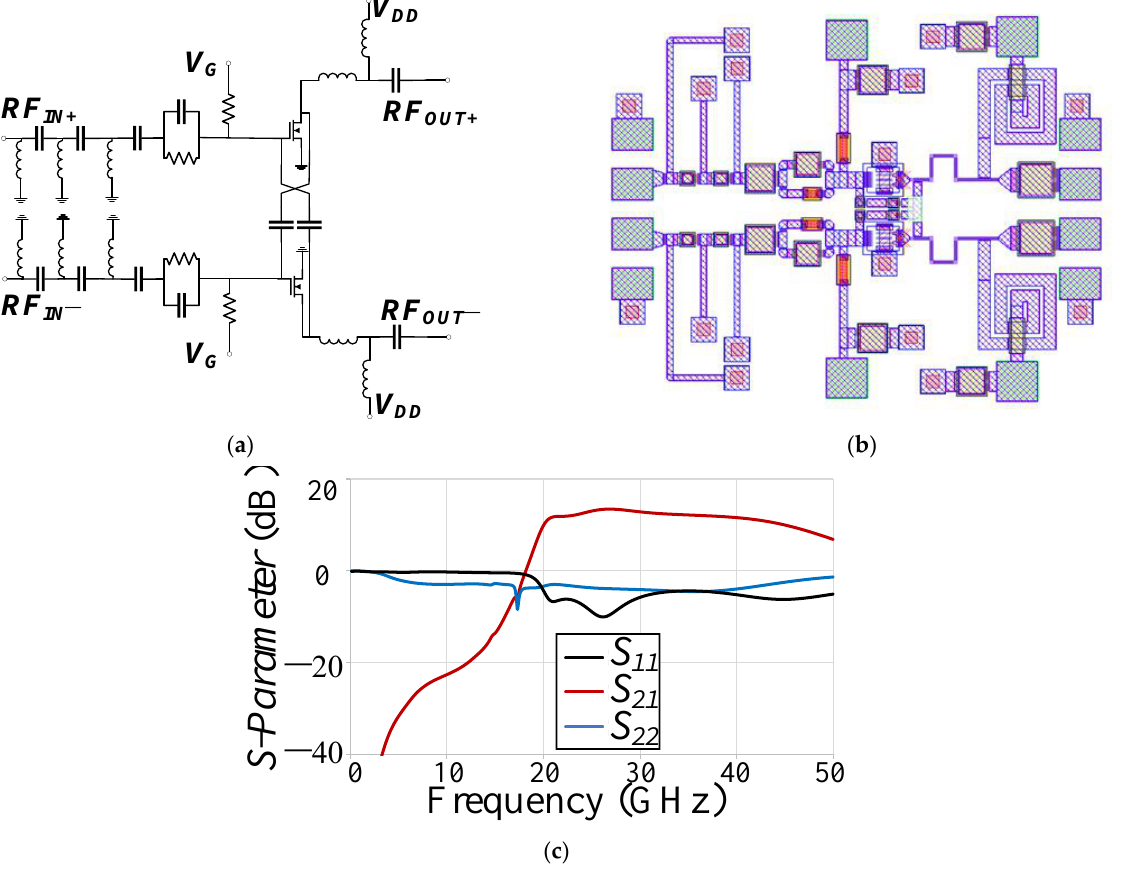
Figure 9. ( a ) Simplified schematics and ( b ) the layout of the broadband differential GaN PA (2.0 × 0.97 mm 2 with pads); and ( c ) its S-Parameter EM PEX simulation results. The large-signal EM simulation results for this differential GaN PA are shown in Figure 10, which indicates that this PA can achieve a maximum PAE of 24.9%/26.6%/23.3% and P OUT,SAT of 23.5/23.6/23.3 dBm at 24/28/44 GHz. Figure 11 shows the broadband nature of this PA, as it is able to achieve >20% maximum PAE across the 20 – 44 GHz band, and has a very high simulated 1-dB P OUT,SAT BW and also P OUT,SAT larger than ~23 dBm in the 5G FR2 band of interest. Compared to the measured GaN #1 PA, it achieves a similar maximum PAE, while having ~3 dB greater P OUT,SAT than the single-ended design. We will discuss another broadband differential mm-Wave 5G PA designed in 22 nm FD-SOI CMOS next.